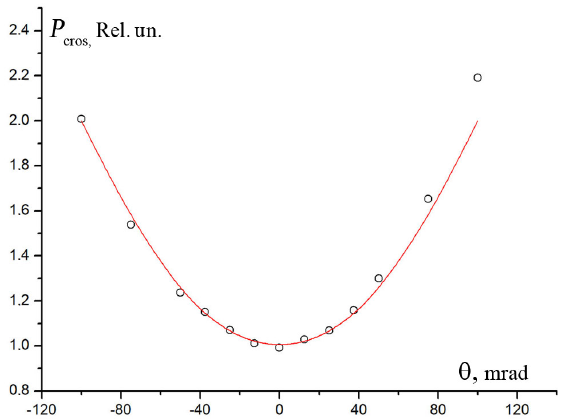
Figure 3. Adjusting the position of the Glan prism. The dependence of the cross-polarized component P cros (normalized to the mini- mum is 1) on the angle θ of the prism rotation is shown. Measured values P cros (circles) and fitting curve (red